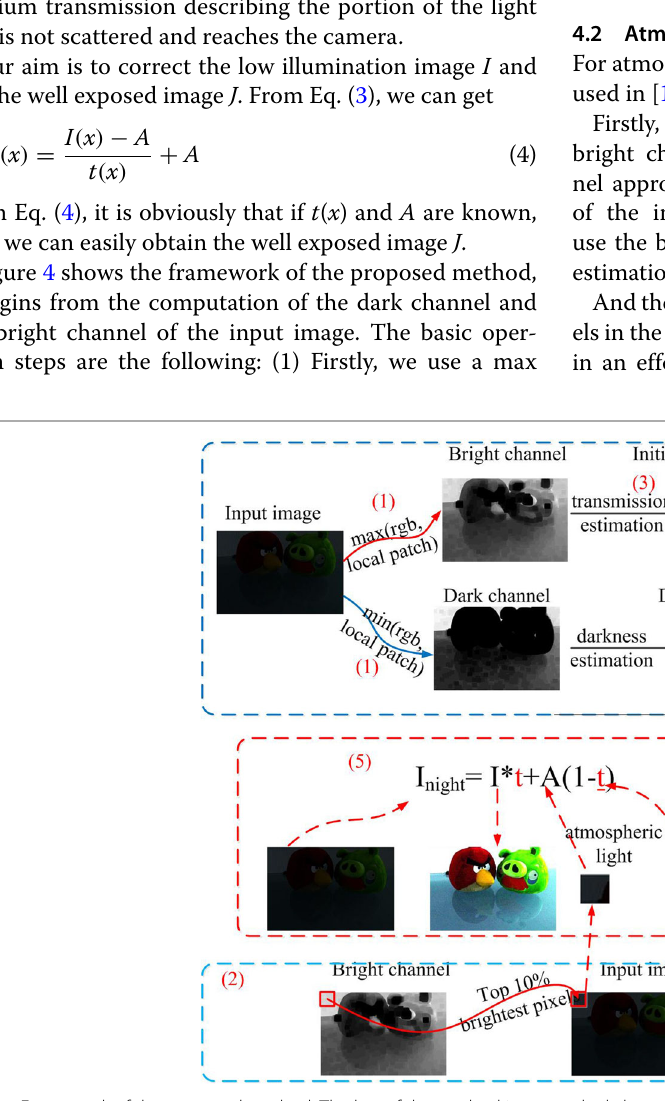
Fig. 4 Framework of the proposed method. The key of the method is to use dual channel prior for transmission estimation. We utilize the bright channel prior to get an initial transmission first, and then use the dark channel as a complementary information to correct potentially erroneous transmission estimations attained from the bright channel